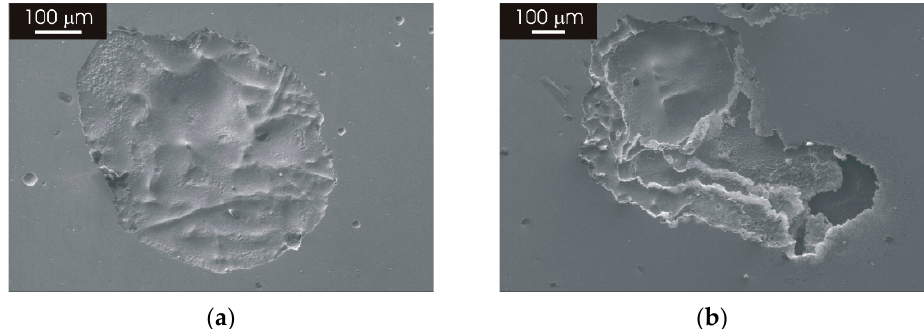
Figure 12. SEM micrographs of L-PBF-XY 316L stainless steel after galvanostatic polarization at 1 mA/cm − 2 for 1 h in 3.5 NaCl solution. ( a ) Heat treated at 1100 °C for 8 h; ( b ) heat treated at 1100 °C for 24 h.